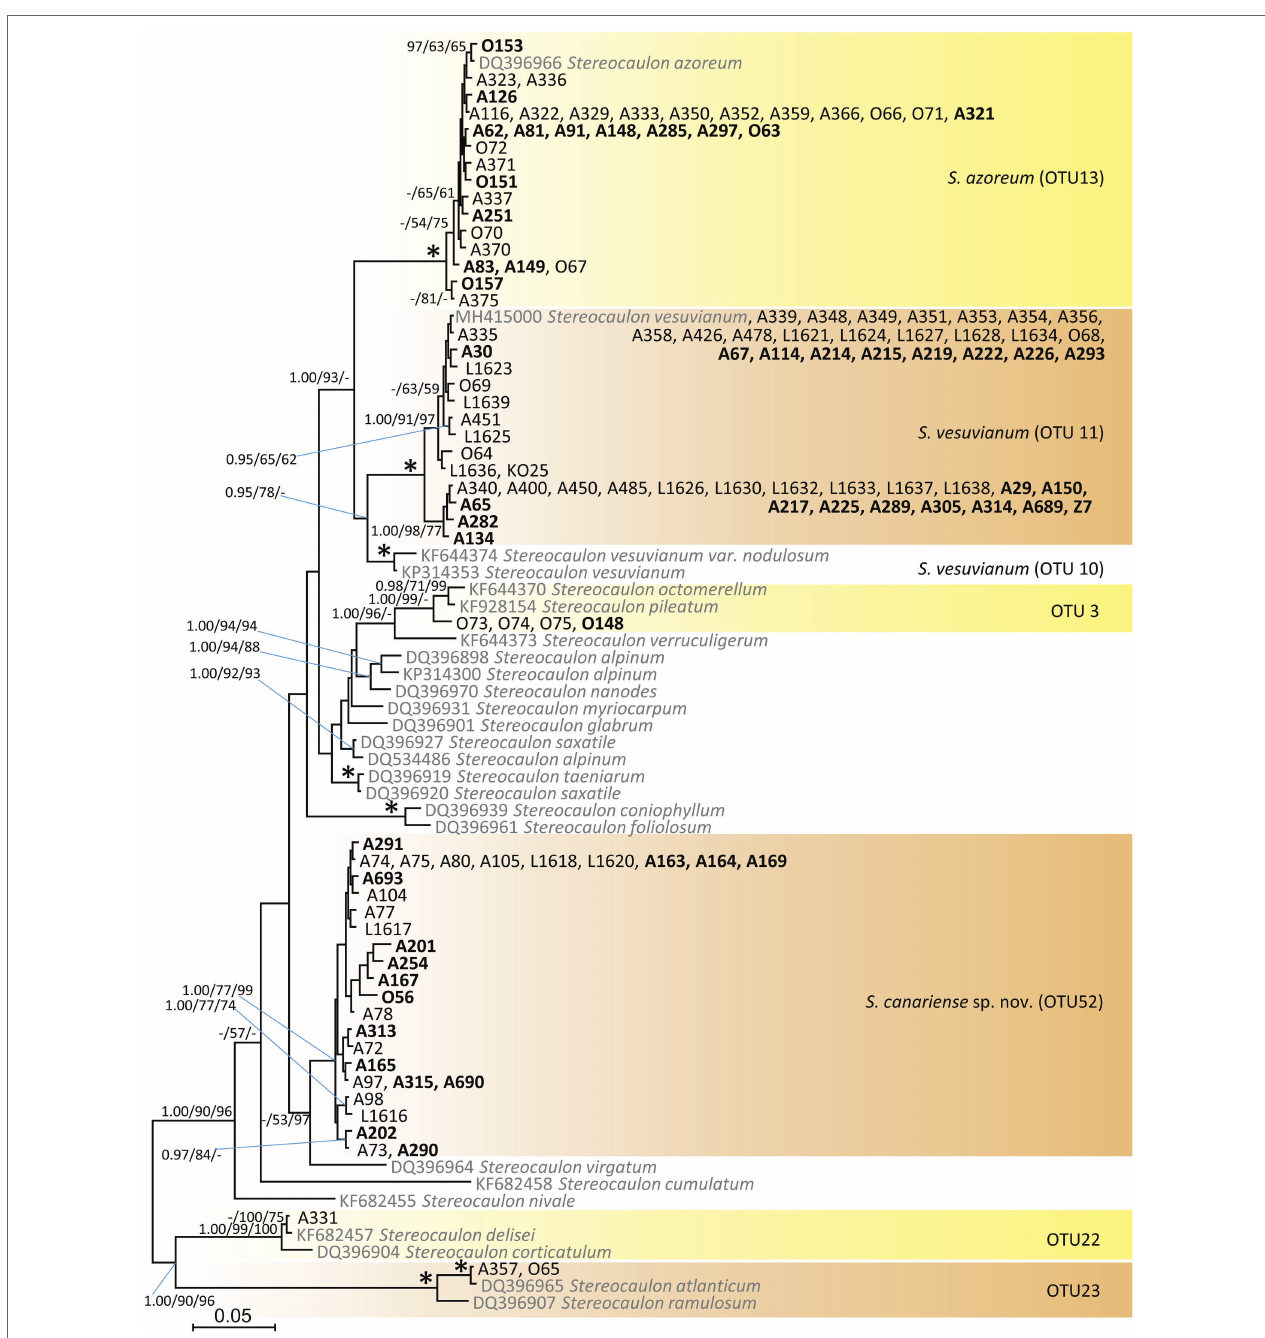
FIGURE 1 | Phylogenetic hypothesis (unrooted tree) of Stereocaulon resulting from Bayesian analysis of ITS rDNA. Values at the nodes indicate the statistical supports of Bayesian posterior probability (left), maximum-likelihood bootstrap (middle) and maximum parsimony bootstrap (right). Fully supported branches (1.0/100/100) are marked with an asterisk. Scale bar shows the estimated number of substitutions per site. Newly obtained sequences are marked in bold. We selected the reference sequences from GenBank (in grey) taking care to cover eight main Stereocaulon clades (Högnabba, 2006).